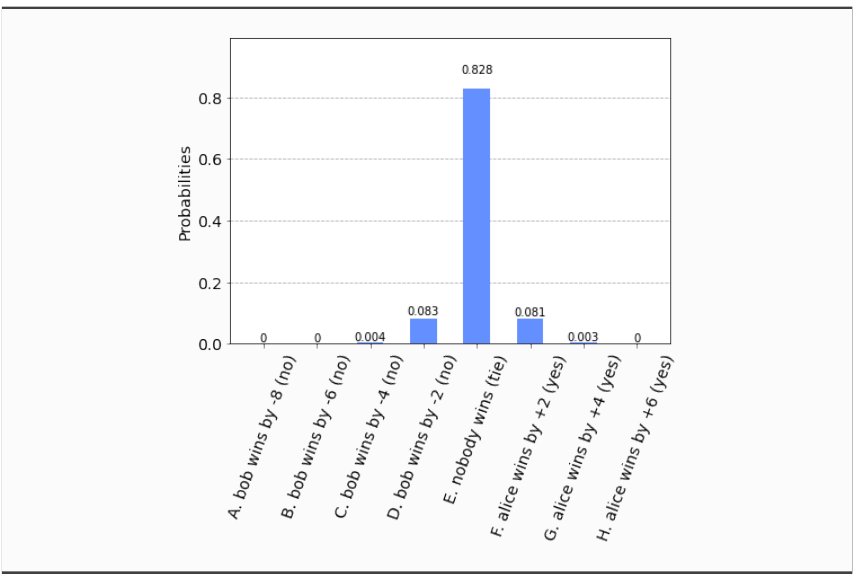
Figure 25. The possible outcomes when n A = n B = 8, r A = r B = 0.2, and n I = 0.